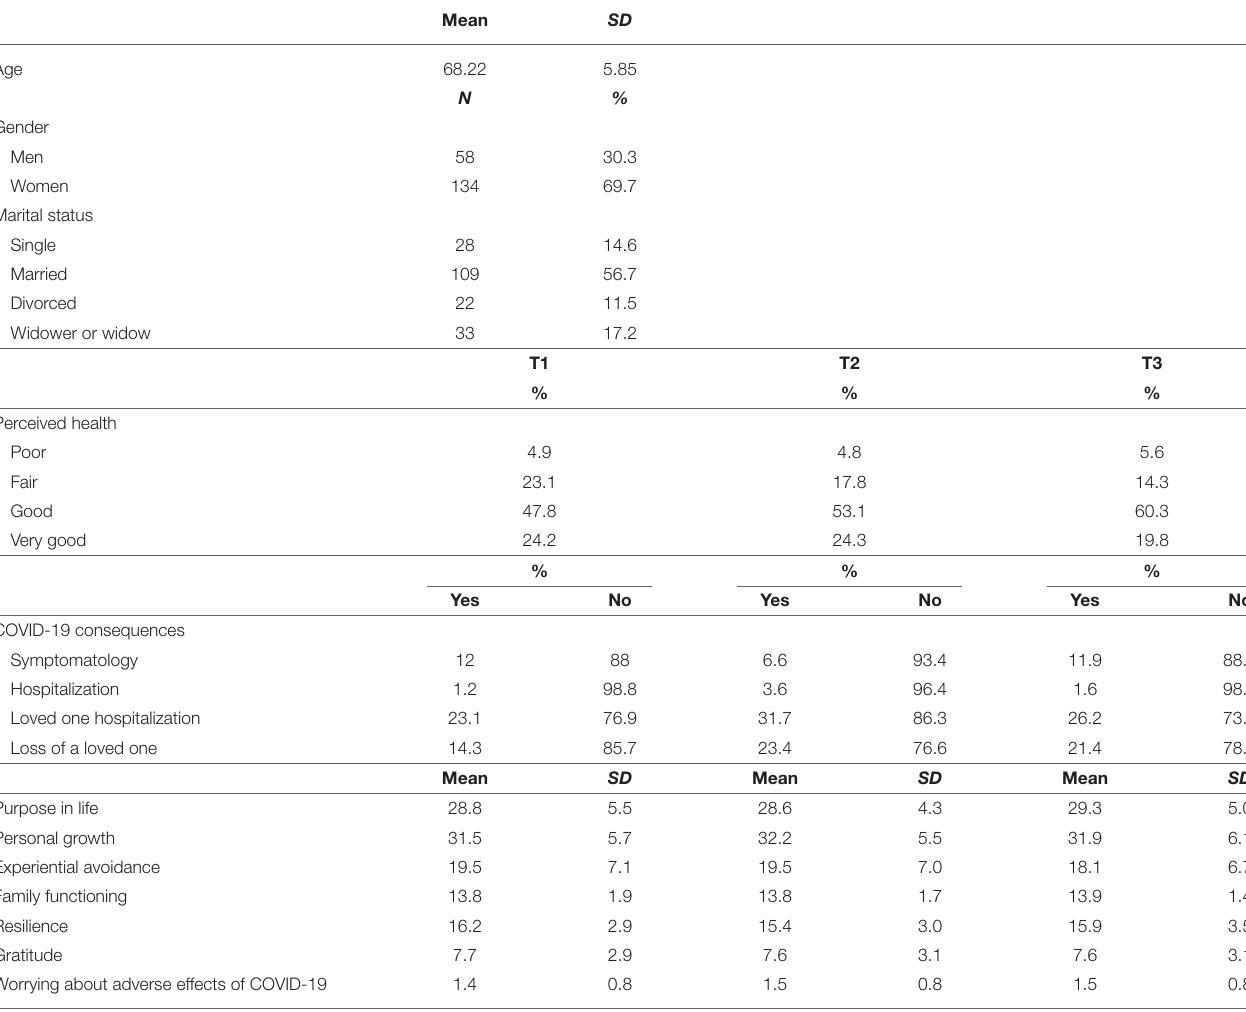
TABLE 1 | Descriptive analysis along the three measurement occasions of the longitudinal